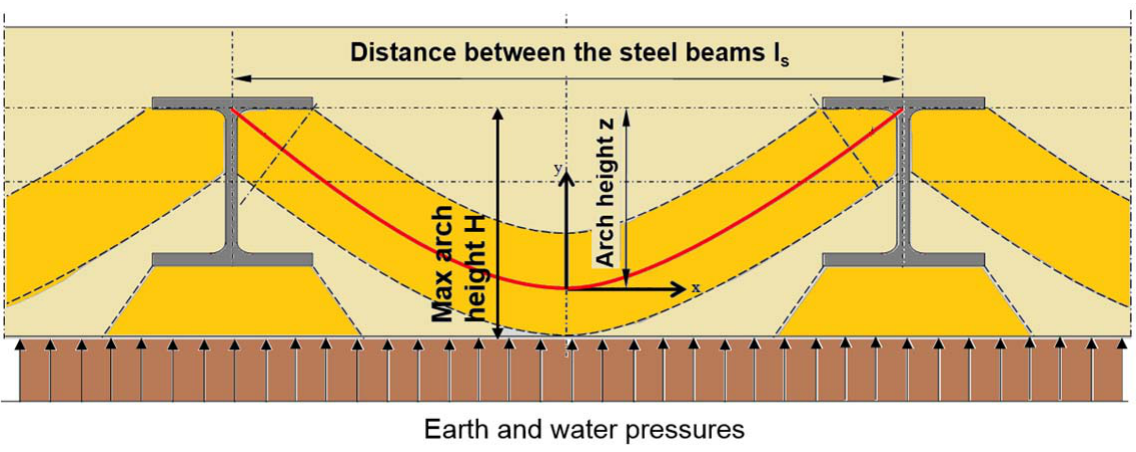
Figure 3. Working principle of a soil mix retaining wall: illustration of the arching